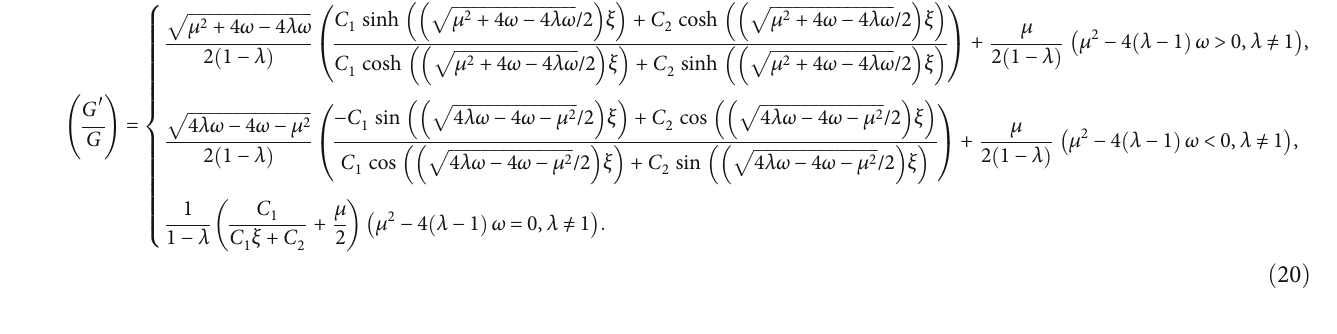
ffiffiffiffiffiffiffiffiffiffiffiffiffiffiffiffiffiffiffiffiffiffiffiffiffiffiffiffi p ffiffiffiffiffiffiffiffiffiffiffiffiffiffiffiffiffiffiffiffiffiffiffiffiffiffiffiffi μ 2 + 4 ω − 4 λω ffiffiffiffiffiffiffiffiffiffiffiffiffiffiffiffiffiffiffiffiffiffiffiffiffiffiffiffi p ffiffiffiffiffiffiffiffiffiffiffiffiffiffiffiffiffiffiffiffiffiffiffiffiffiffiffiffi 4 λω − 4 ω − μ 2